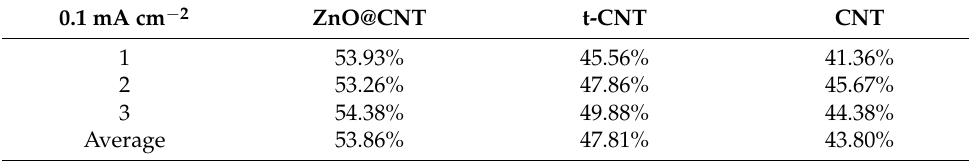
Table 1. Yield of Li 2 O 2 after the first discharge as measured by iodine-metric